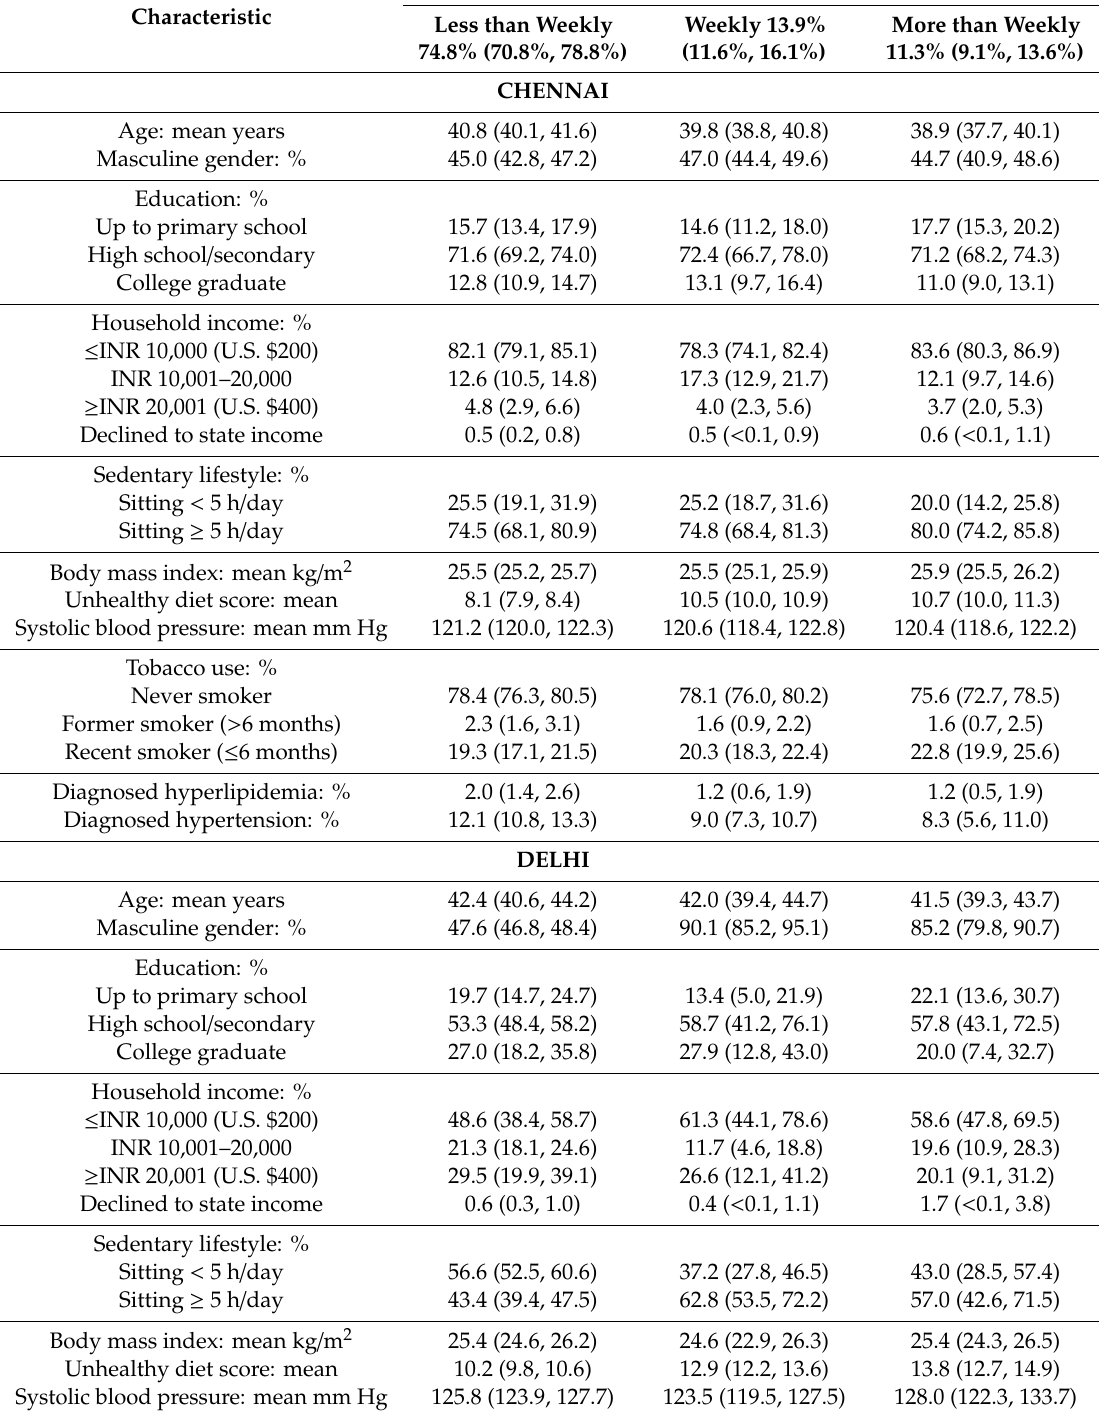
Table 2. Estimated population characteristics, by city and shellfish consumption. Survey estimation techniques were used to obtain estimates of population means and proportions. Here, the category “less than weekly” indicates that shellfish is consumed monthly or never. Disjoint categories within a column, within each city, sum to 100% (with rounding). Statistics are estimates for the characteristics of each city’s population of permanent residents age ≥ 20 years old, who are neither pregnant nor on bedrest. Population parameter estimates are based a large survey sample including participants from Karachi (unweighted n = 4017), Delhi (unweighted n = 5364), and Chennai (unweighted n = 6906). Shellfish Consumption (Estimates and 95% Confidence Intervals) Characteristic Less than Weekly Weekly 13.9% 74.8% (70.8%, 78.8%) (11.6%, 16.1%) 11.3% (9.1%,